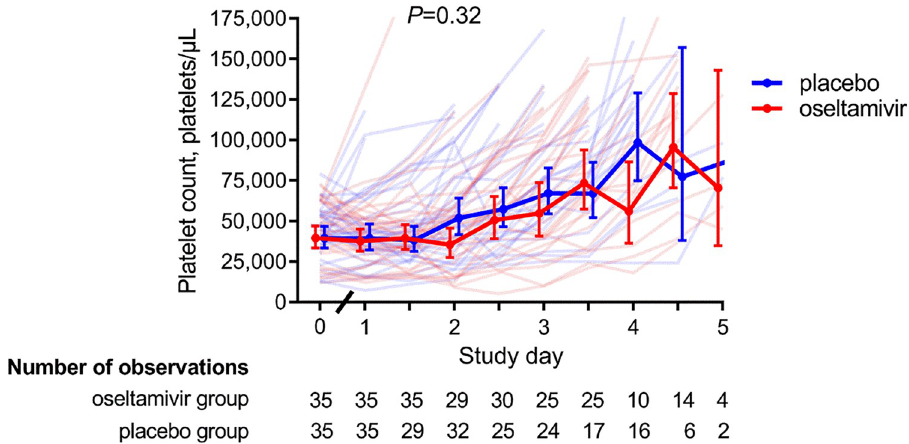
Fig 2. Twice daily platelet count. Data depicted are individual values (transparent lines) and geometric mean (solid line) with 95% confidence interval. P value calculated using mixed model method.